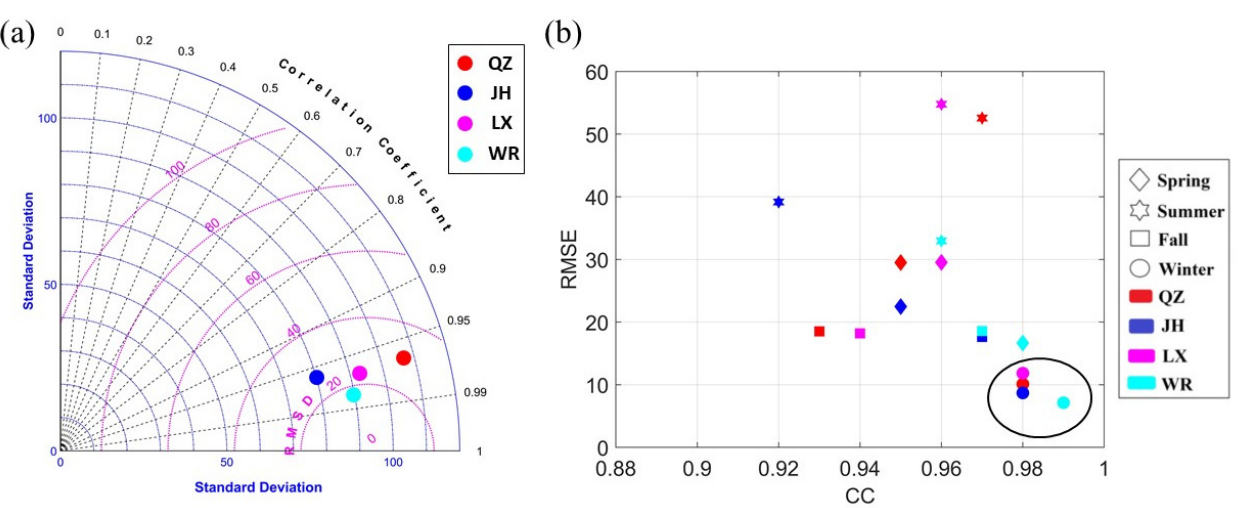
Figure 4. ( a ) Taylor diagram of monthly scale observations and APHRODITE precipitation products and ( b ) comparison of the accuracy of observations and APHRODITE precipitation products on seasonal